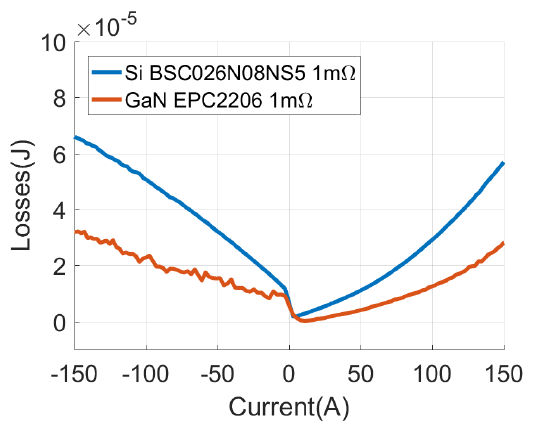
Figure 13. Simulated switching losses of four paralleled GaN (EPC2206) and Si (BSC026N08NS5) MOSFET, at 28 VDC.